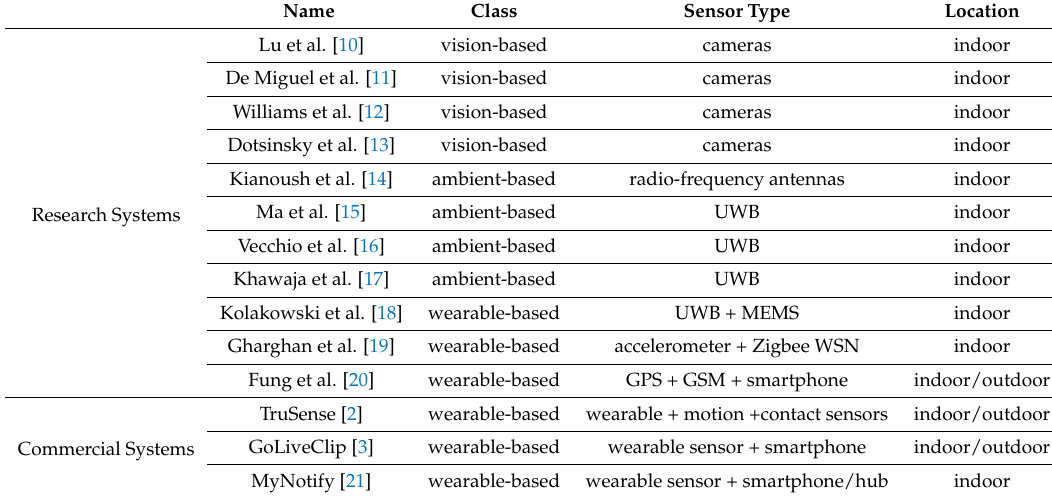
Table 1. Examples of recently developed fall detection